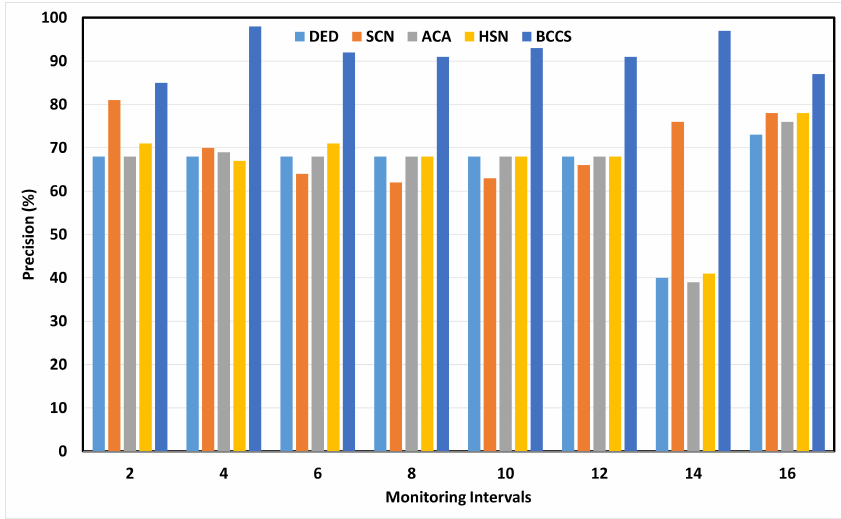
Figure 5. Precision (monitoring intervals).